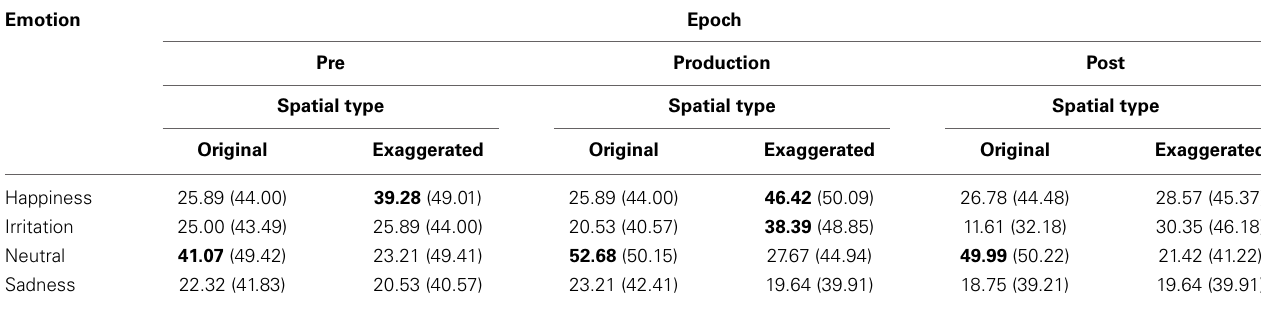
Table 3 | The average accuracy ratings for each emotion and epoch for the original and exaggerated scrambled